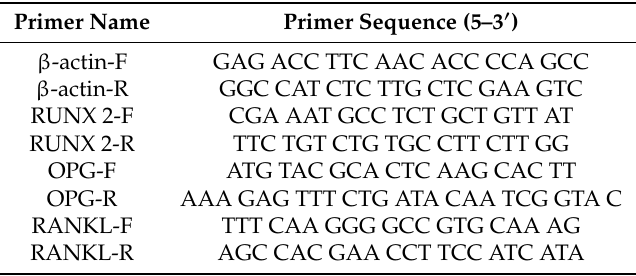
Table 3. qPCR primer